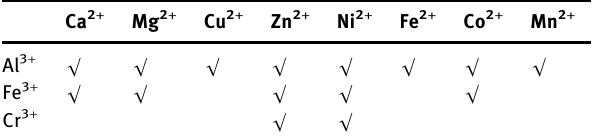
Table 2: Combination of divalent and trivalent cations in